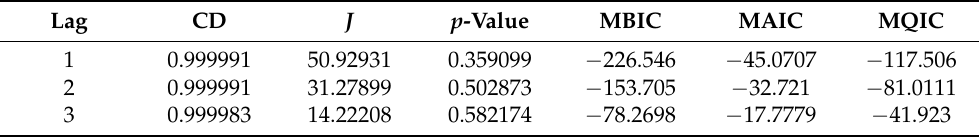
Table 3. Optimal lag order of PVAR model.